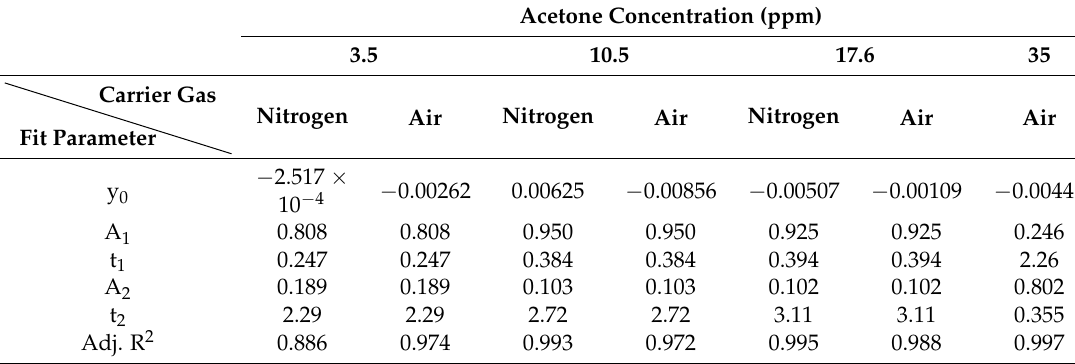
Figure 7. ( a ) Normalised current plots representing descending P3HT nanofibers sensor’s traces after exposure to the gas analyte (acetone at 3.5, 10.5 and 17.6 ppm) in nitrogen as the carrier gas, at 25 ◦ C. ( b ) Normalised current plots representing descending portions of P3HT nanofibers sensor’s traces after exposure to the gas analyte (acetone at 3.5, 10.5, 17.6 and 35 ppm) in air as the carrier gas, at 25 ◦ C. Table 2. Fitting curve parameters for the tested acetone concentrations under different carrier